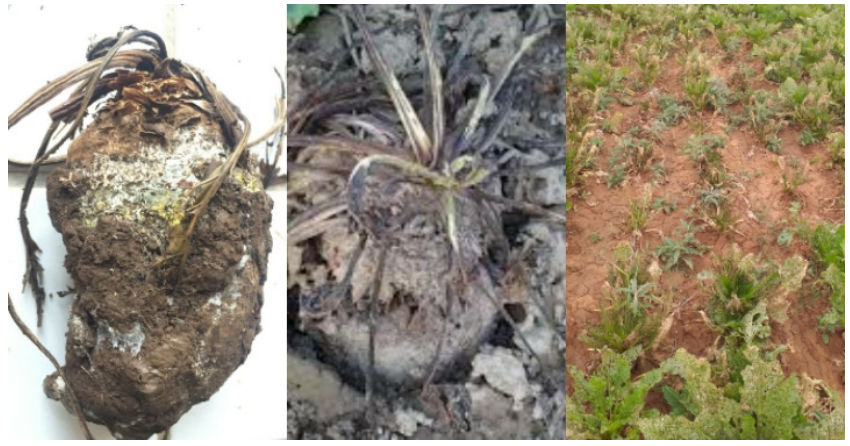
Figure 1. Symptomatic sugar beet roots and field with the isolated Fusarium spp. causal agent of root rot disease in Beni Mellal, Morocco.